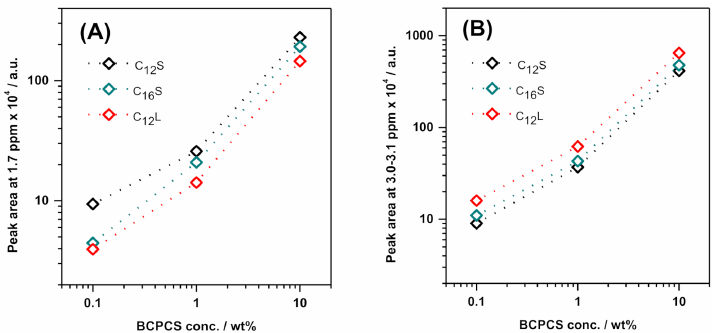
Figure 3. Variation of peak areas at ( A ) 1.7 ppm (composite peak associated with the polyion) and ( B ) 3.0–3.1 ppm (surfactant peak) in the dilute phase obtained in the centrifuged samples as a function of overall initial BCPCS concentration. The lines are guides to the eye. Note the log–log scale. The terms C 12 and C 16 denote the surfactant alkyl chain length, and S and L refer to the length of the PAAm block in the BCP (short and long,